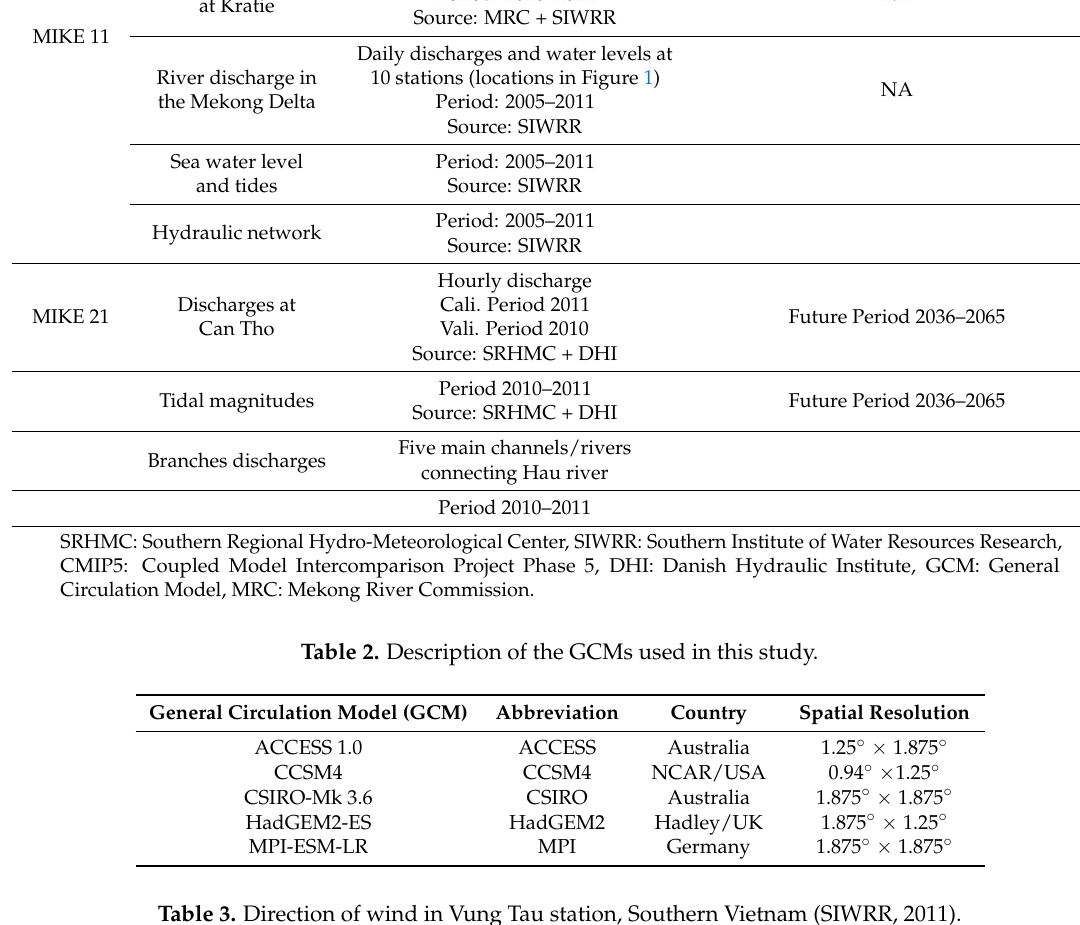
Table 3. Direction of wind in Vung Tau station, Southern Vietnam (SIWRR,